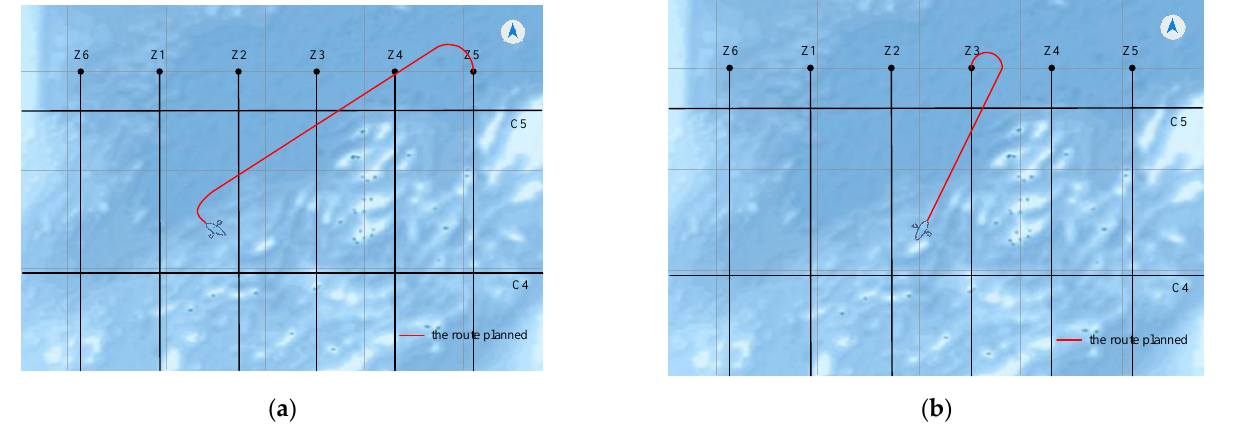
Figure 13. Navigation sea routes in an intelligent vessel navigation system: ( a ) the navigation trajectory used route 1; ( b ) the navigation trajectory used route 1 ″ . The data are mainly measured based on line AB in the main survey lines. Table 1 indicates some test points. The minimum turning radius is 100 m. The latitude and longitude of the points are expressed in coordinates for calculation. Table 2 shows the total distance of each sea route proposed in this